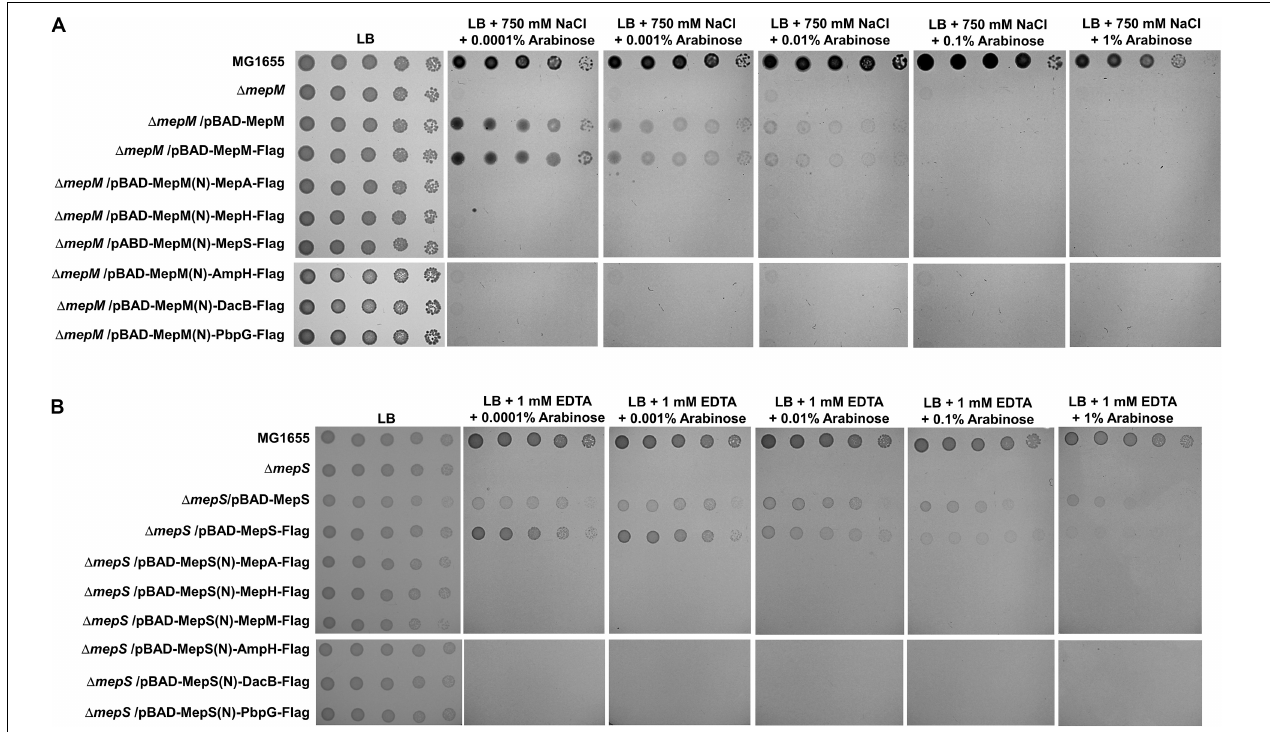
FIGURE 4 | Distinct roles of MepM and MepS are not due to their unique localization. (A) The wild-type, mepM mutant, and mepM mutant cells harboring the indicated plasmids were serially diluted from 10 8 to 10 4 cells/mL in 10-fold steps and spotted onto an LB plate or LB plates containing 750 mM NaCl and the indicated concentrations of arabinose. (B) The wild-type, mepS mutant, and mepS mutant cells harboring the indicated plasmids were serially diluted from 10 8 to 10 4 cells/mL in 10-fold steps and spotted onto an LB plate or LB plates containing 1 mM EDTA and the indicated concentrations of